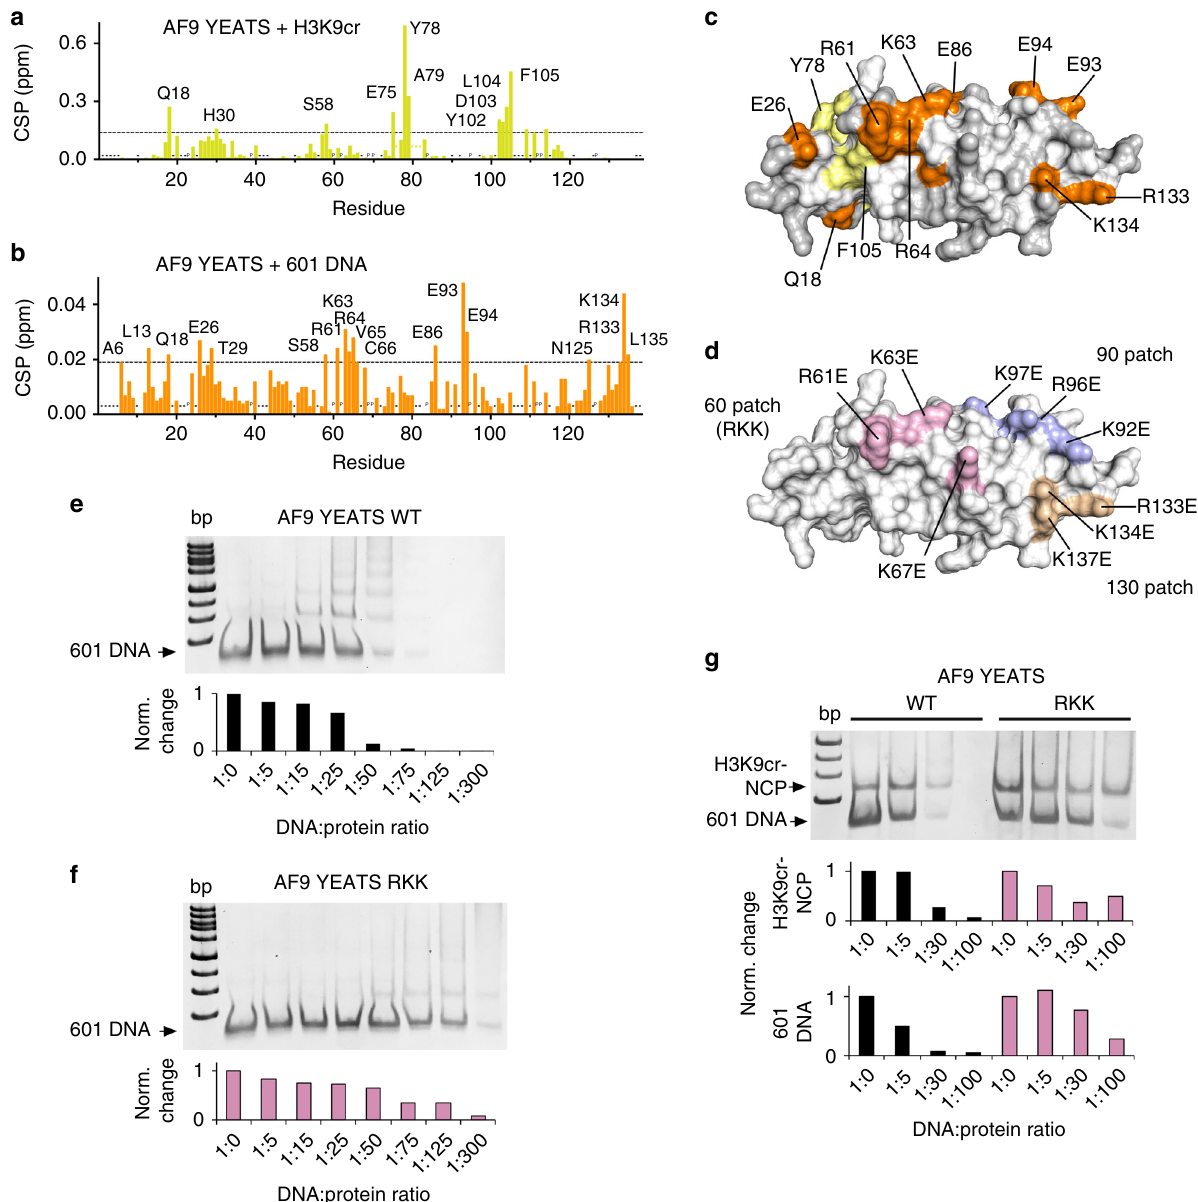
Fig. 6 DNA- and H3K9cr-binding sites in AF9-YEATS do not overlap. a , b Analysis of chemical shift perturbations in 1 H, 15 N HSQC spectra of AF9-YEATS caused by ( a ) H3K9cr peptide (1:3 molar ratio) or ( b ) 601 DNA (1:0.5 molar ratio). P indicates a proline residue. ‘ * ’ indicates that the residue resonances were unassigned in the apo-state. ‘ - ’ indicates that the residue resonances were unassigned in the H3K9cr-bound state (BMRB 26060). Dashed line indicates selection cut-off (mean + 3 SD). Residues with CSP above the cut-off value are labeled. c Identi fi cation of the H3K9cr peptide- and 601 DNA- binding sites. Residues with CSP above the cut-off value in ( a , b ) are mapped onto the surface of AF9-YEATS (PDB 5hjb), colored yellow and orange, respectively, and labeled. Residues with no assignments or prolines are colored light gray. d The 60th patch (R61K/K63E/K67E, light pink), 90th patch (K92E/R96E/K97E, light blue), and 130th patch (R133E/K134E/K137E, wheat) mutations are mapped onto the surface of AF9-YEATS. e – g EMSA assays with 1 pmol/lane 601 DNA ( e , f ) or 1 pmol/lane H3K9cr-NCP ( g ) incubated with increasing amounts of WT AF9-YEATS or RKK mutant. Band intensities were quanti fi ed by densitometry using